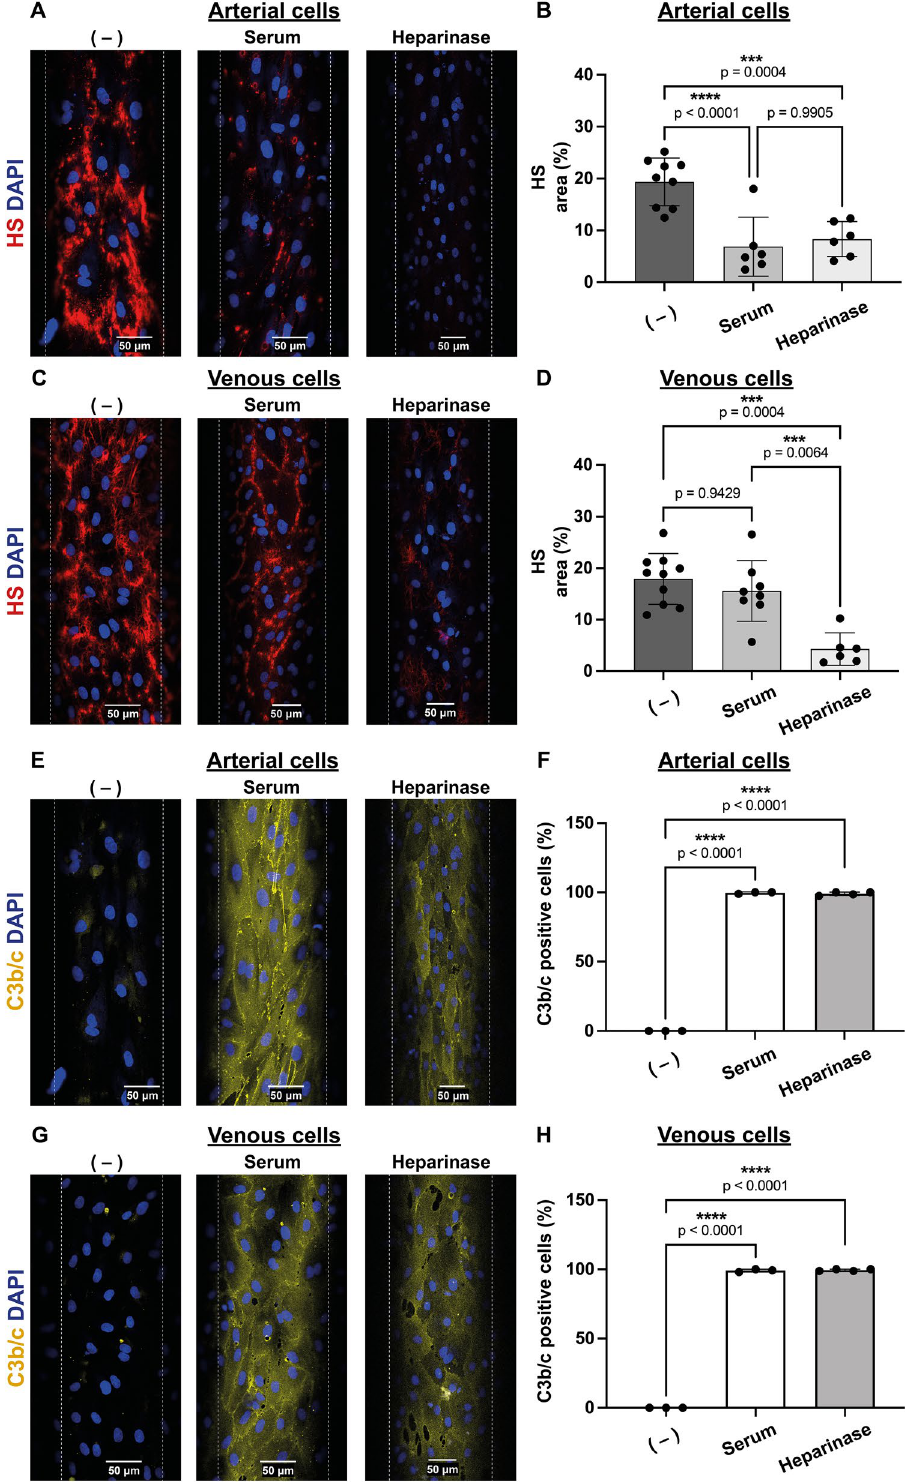
Figure 2. Resistance of heparan sulfate shedding on xenogeneic activated venous cells does not prevent C3b/c deposition. ( A , C ) Representative images of heparan sulfate (HS) on the cell surface of cells left untreated (−), perfused with 10% normal human serum (Serum) or 5 U/ml heparinase (Heparinase). HS is shown in red and nuclei in blue (DAPI). Scale bar: 50 μm ( B , D ) Shedding of HS was quantified for each image (4 images/condition/experiment) as the percentage of area positive for HS and normalized for the total number of cells/image. ( E , G ) Representative images of complement C3b/c deposition on the cell surface of cells left untreated (−), perfused with 10% normal human serum (Serum) or 5 U/ml heparinase (Heparinase). C3b/c is shown in yellow and nuclei in blue (DAPI). Scale bar: 50 μm ( F , H ) C3b/c deposition was measured as the percentage of C3b/c positive cells/total number of cells/image (4 images/condition/experiment). Data was quantified with Fiji software. All images were acquired with a Zeiss LSM980 confocal microscope. Data are from three or more independent experiments and 2–3 different porcine ECs donors. One-way ANOVA with multiple comparisons was used for statistical